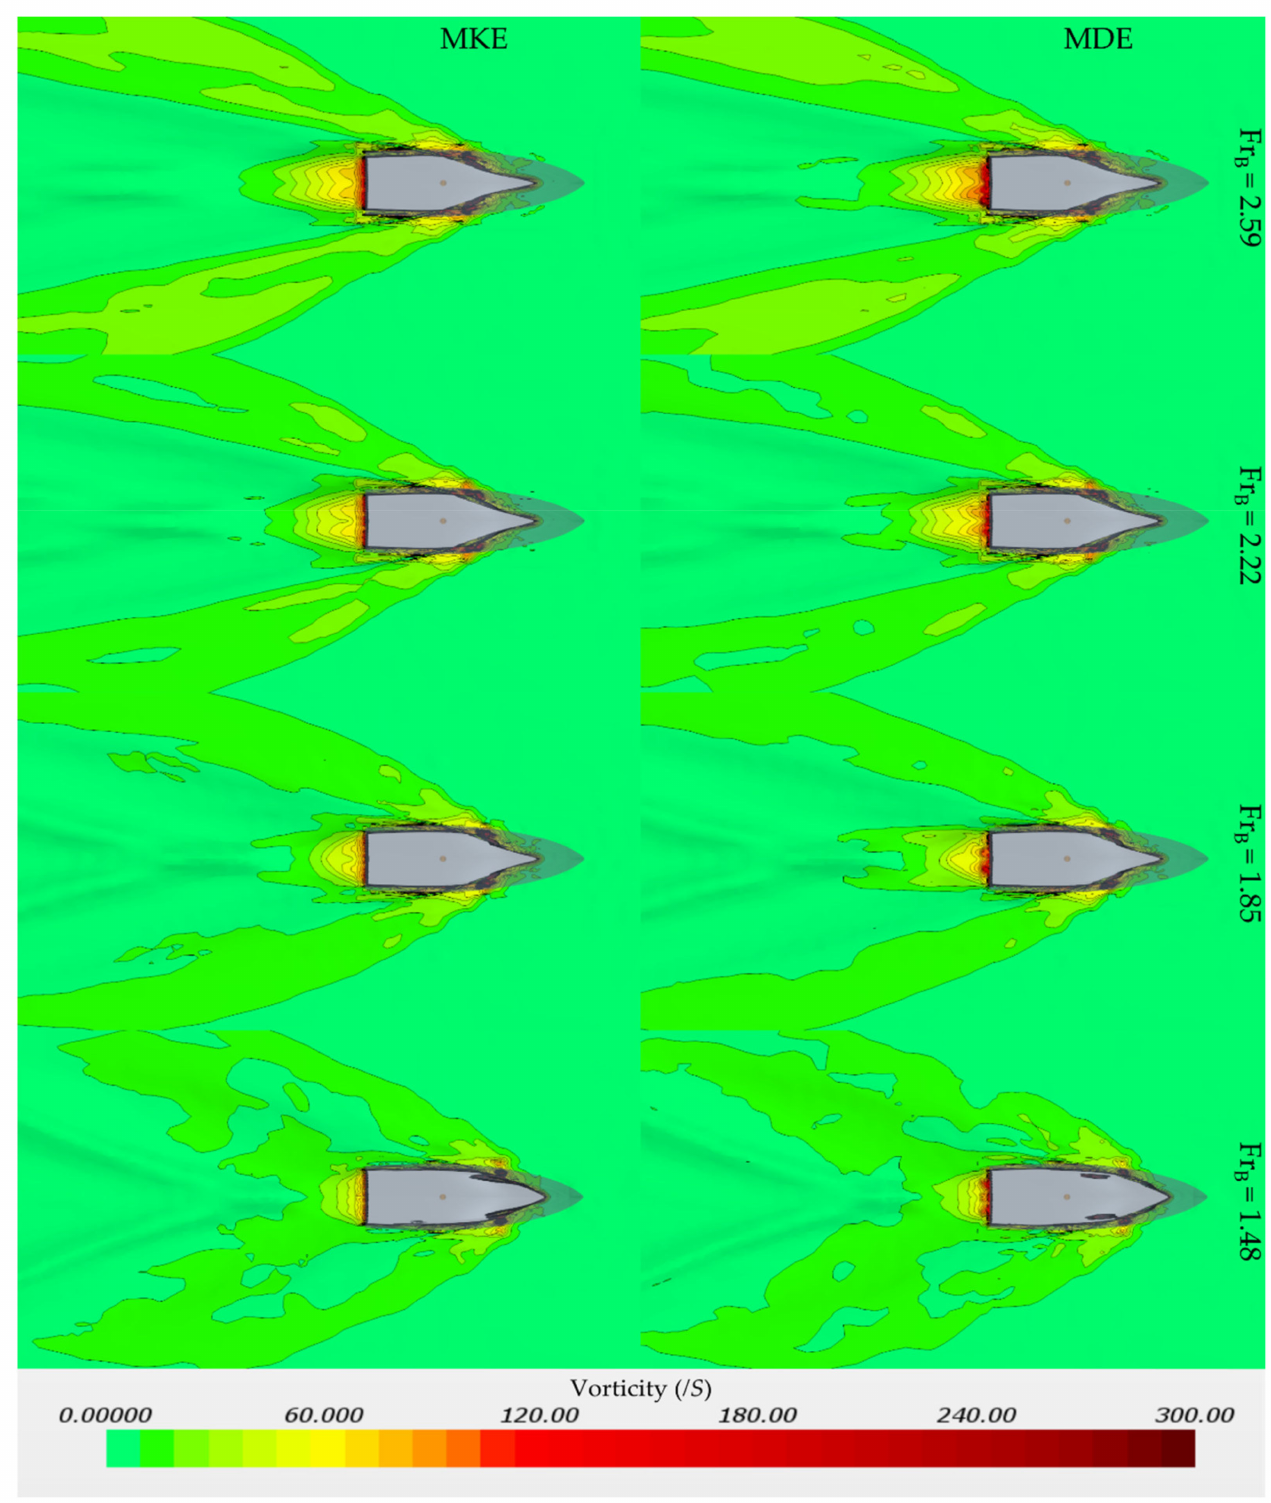
Figure 15. A top view of vorticity contours around the modeled planing vessel at different speeds. The results correspond to CFD simulations performed by employing the morphing mesh technique. The left panels show the data corresponding to k- ε model, and the right panels show the data corresponding to DES